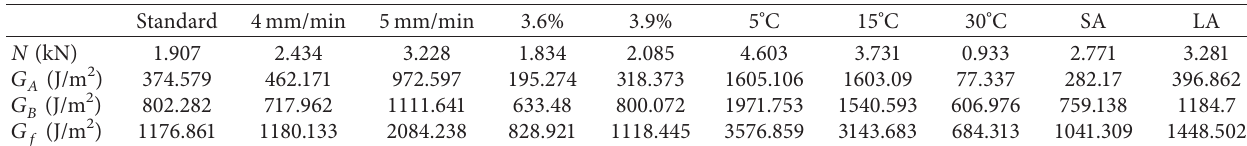
Figure 3: Load-displacement curves of LSAM with monotonic OT corresponding to the (a) loading rate, (b) asphalt aggregate ratio, (c) temperature, and (d) degree of Table 6: Test results of LSAM.